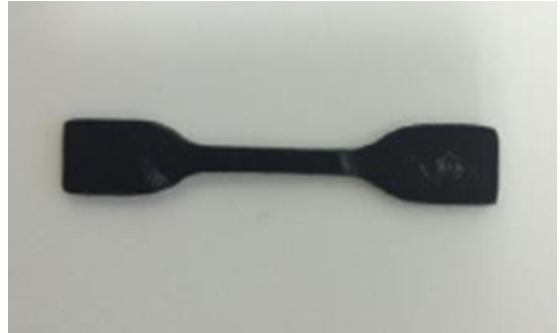
Figure 2. Dumbbell specimen.